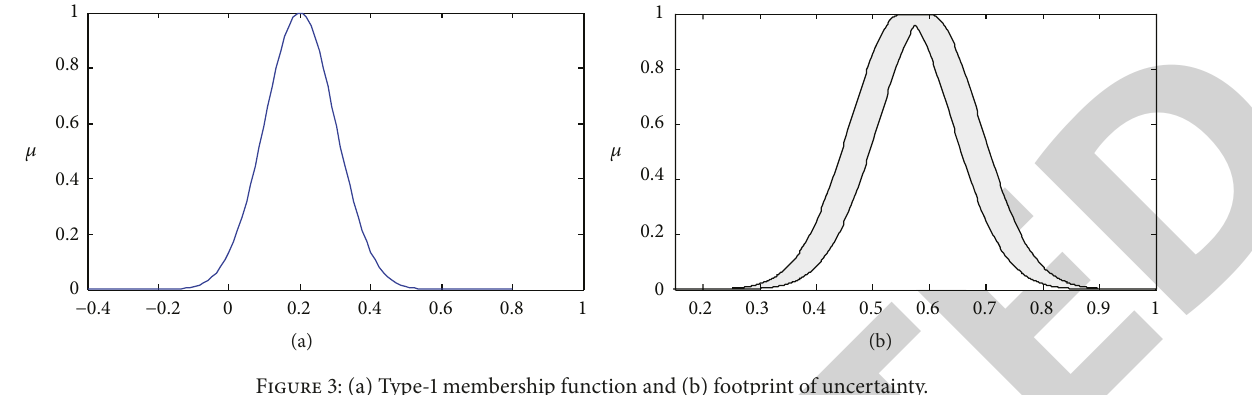
Figure 3: (a) Type-1 membership function and (b) footprint of